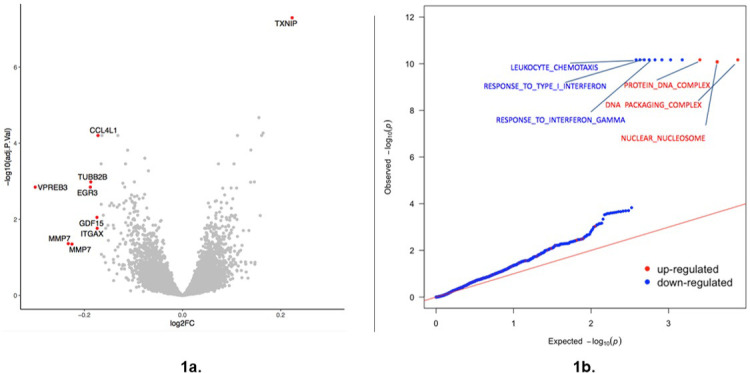
Response to glucose.(a) Volcano plot summarizing transcriptional response to glucose for all 22 individuals (RGAll consisting of nDM, nDR, and PDR individuals). Each point represents a single gene. Red indicates genes showing a differential response (FDR < 0.05; log10 >1.3 represented by the dotted line) and an absolute log2FC >0.17. Adj p-value is false discovery rate (FDR). FC indicates expression fold change with positive values indicating higher expression in the high glucose condition relative to the standard condition. Source and code files for this plot are available in Figure 1—source data 1 and Source code 1. An additional source file can be found in Gene Expression Omnibus (GEO) at https://www.ncbi.nlm.nih.gov/geo/ under accession code GSE146615. (b) QQ (quantile-quantile) plot plot summarizing GSEA of transcriptional response to glucose in all 22 individuals. Pathways are classified as upregulated (red) or downregulated (blue) in response to glucose. Only significant GO categories (FDR < 0.1%) are labeled. Red line indicates the null expectation. Source and code files for this plot are available in Figure 1—source data 2, 3, 4, and 5 and Source code 2.Figure 1—source data 1.RG volcano plot data.Figure 1—source data 2.GSEA QQ plot data.Figure 1—source data 3.GSEA QQ plot data.Figure 1—source data 4.GSEA QQ plot data.Figure 1—source data 5.GSEA QQ plot data.Figure 1—source data 6.p-value distribution plot data.Figure 1—source data 7.Intraindividual variation HG plot.Figure 1—source data 8.Intraindividual variation HG plot.